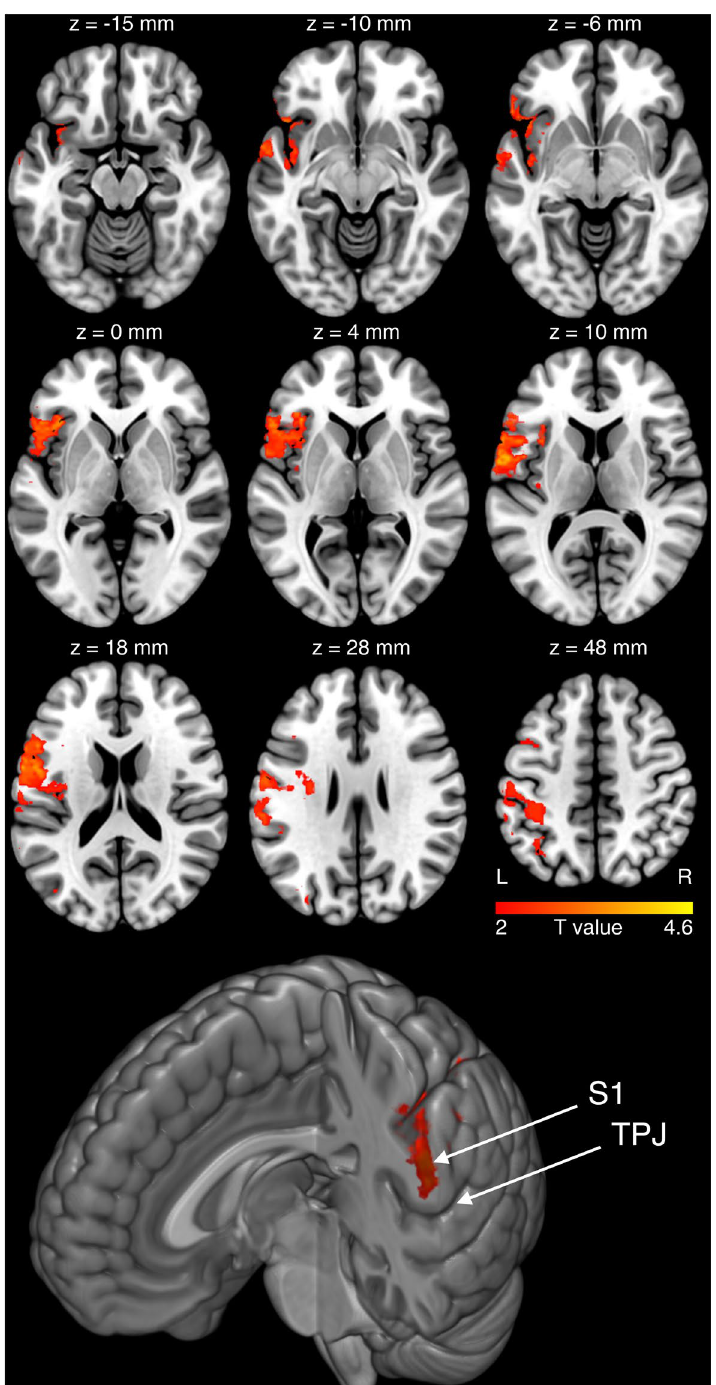
Figure 2. MRI-based lesion symptom mapping. Shown are the brain regions that overlap with an impaired fat perception in the category f3. For f1, we also found significant differences in fat ratings between patients and controls. VSLM, however, revealed no significant effects for f1 (see Fig. 1 for corresponding sugar and fat ratings). The ‘z’ below each brain slice indicates the corresponding z-coordinate of that slice in MNI space. ‘L’ indicates the left and ‘R’ the right hemisphere. We found that an impaired fat perception in f3 overlapped with the anterior insular cortex together with the frontal operculum. Both regions are together assumed to underpin gustatory processing. We also found the mid-dorsal insula together with the primary and secondary somatosensory cortex - regions that are assumed to integrate sensory-oral inputs. At the bottom of the figure we show a render brain with a coronal cut through the primary somatosensory cortex. TPJ indicates the temporoparietal junction, S1 the primary somatosensory cortex. The effect in f3 appears to overlap with the representations of the face including the oral cavity as well as the